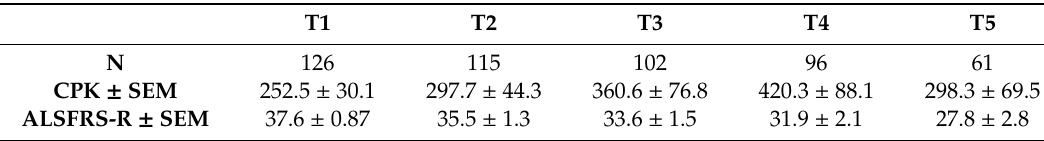
Table 3. CK and ALSFRS-R progression over